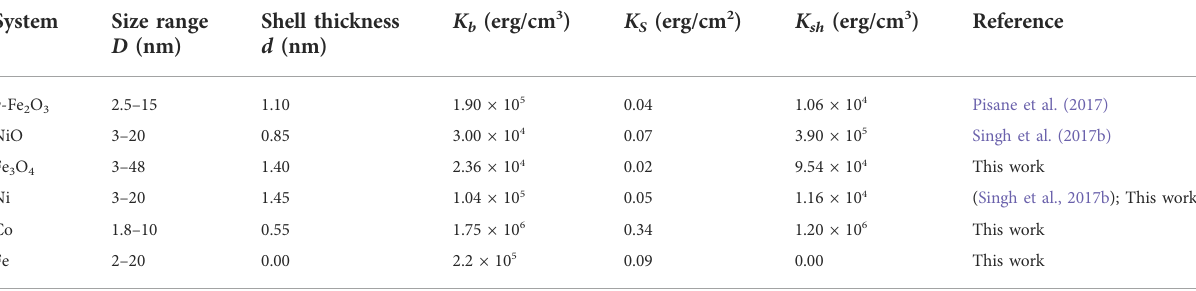
TABLE 1 The effective bulk ( K b ), surface ( K S ), and shell ( K sh ) magnetic anisotropies along with the shell thickness ( d ) obtained from fi tting the CSSL model for maghemite ( γ -Fe 2 O 3 ), NiO, Fe 3 O 4 , Ni, Co, and Fe nanoparticles. System Size range D